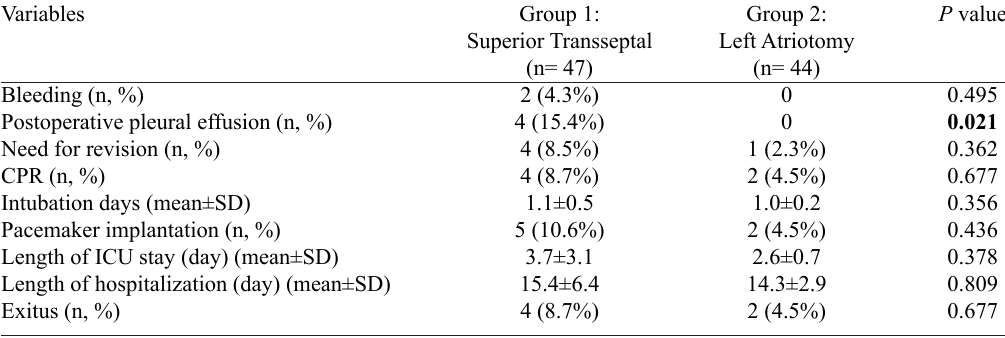
Table 4. A comparison of postoperative variables between the